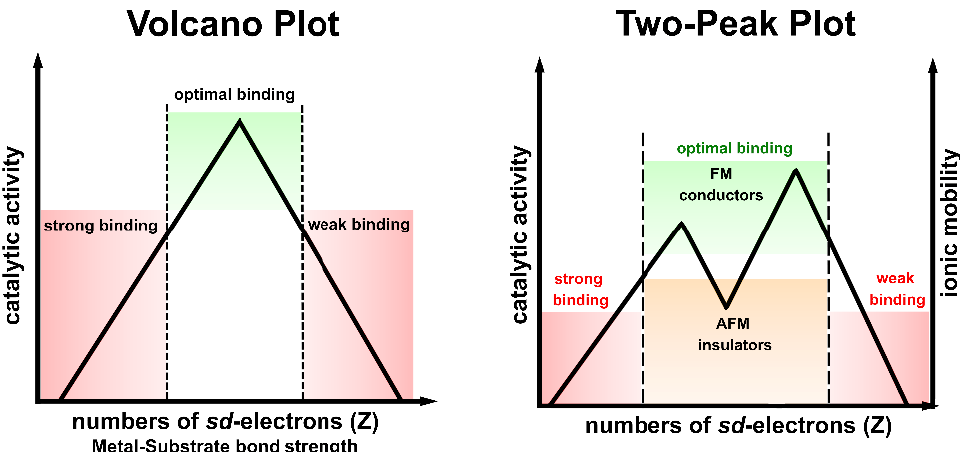
Figure 13. Schematic example of a volcano plot ( left ) and of a multipeak plot ( right ). The volcano- shaped curve shown refers to a general catalytic process, obtained by plotting the catalytic activity vs. the respective metal – substrate bond strength for a series of metal catalysts. Instead, the two-peak structure describes the catalytic activity trend of 3d metal-based catalysts with comparable coordination and oxidation states vs. the oscillation of their magnetic properties correlated to the orbital filling [19]. Adapted with permission from Biz, C.; Fianchini, M.; Gracia, J. Strongly Correlated Electrons in Catalysis: Focus on Quantum Exchange. ACS Catalysis 2021, 11 (22), 14249 – 14261. Copyright 2021, American Chemical Society.